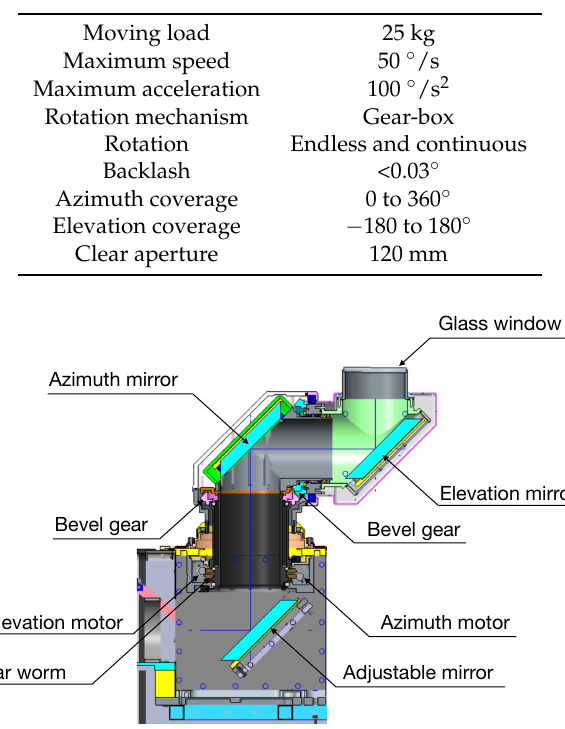
Table 3. Scanner characteristics.